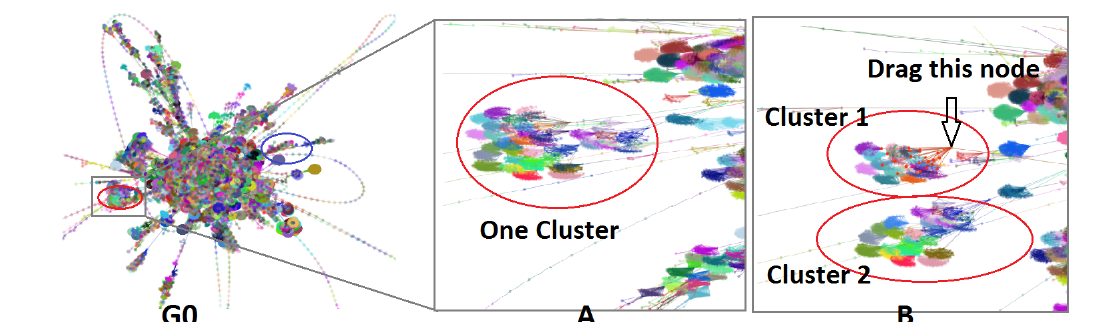
Figure 1. Interacting with a very large graph layout using our GPU algorithm. G 0 is graph layout of web-Stanford data (graph nodes colored by cluster membership). The red and blue circles are highlighted sub-graphs. ( A ) shows the detailed layout when the user zooms into the red circle. ( B ) shows that one cluster separates into two clusters when the user drags a hub node. In Section 6.1, more details are